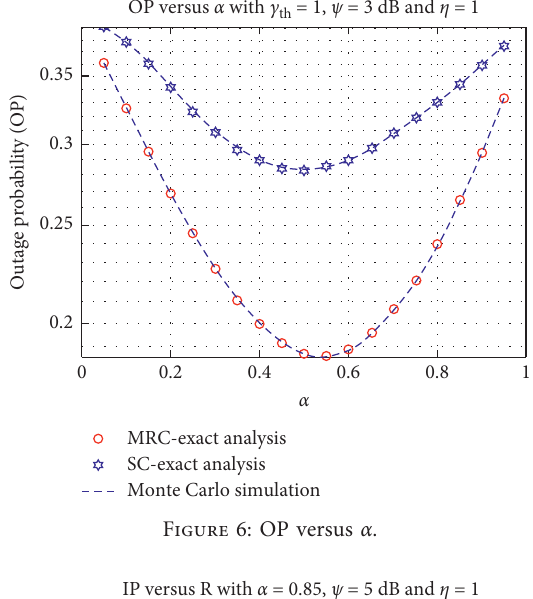
Figure 6: OP versus α .